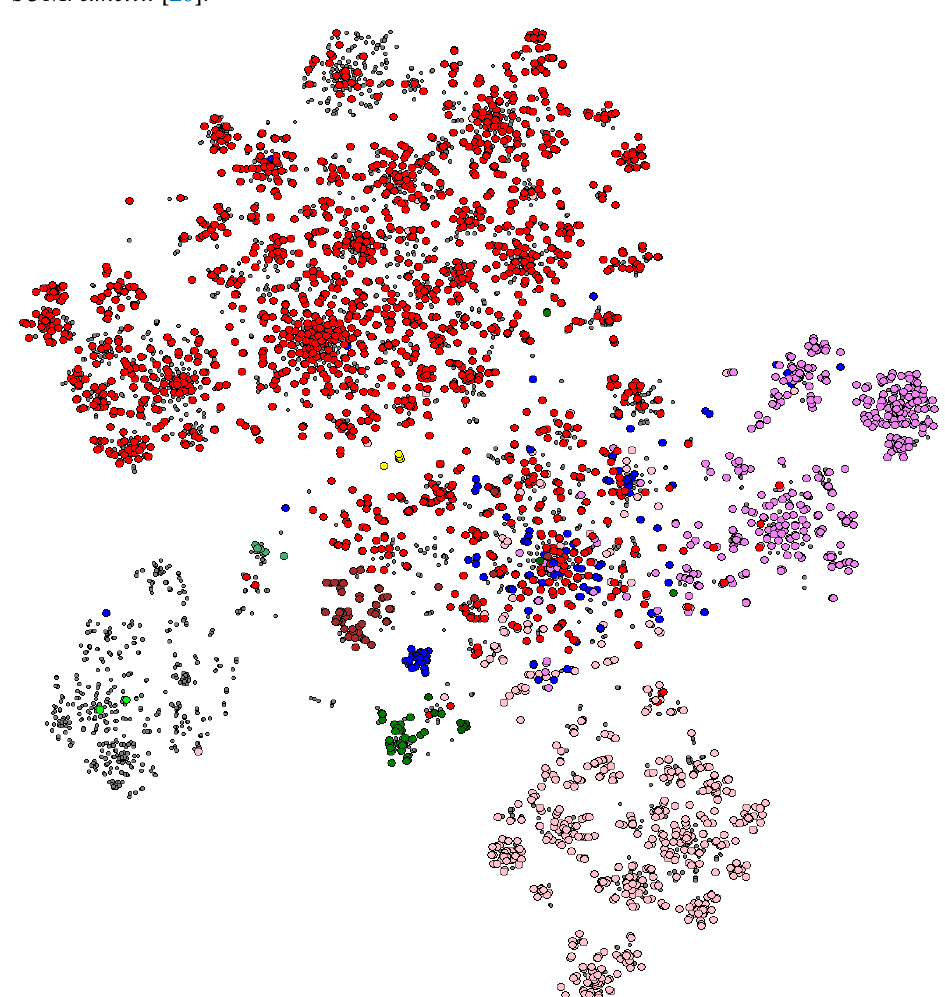
Figure 2. A 2D visualization of the MTC’s spoligotypes. Each point corresponds to one strain (in WGS genome form), while the color of these points is made according to the strain lineage as defined by the presence of classification